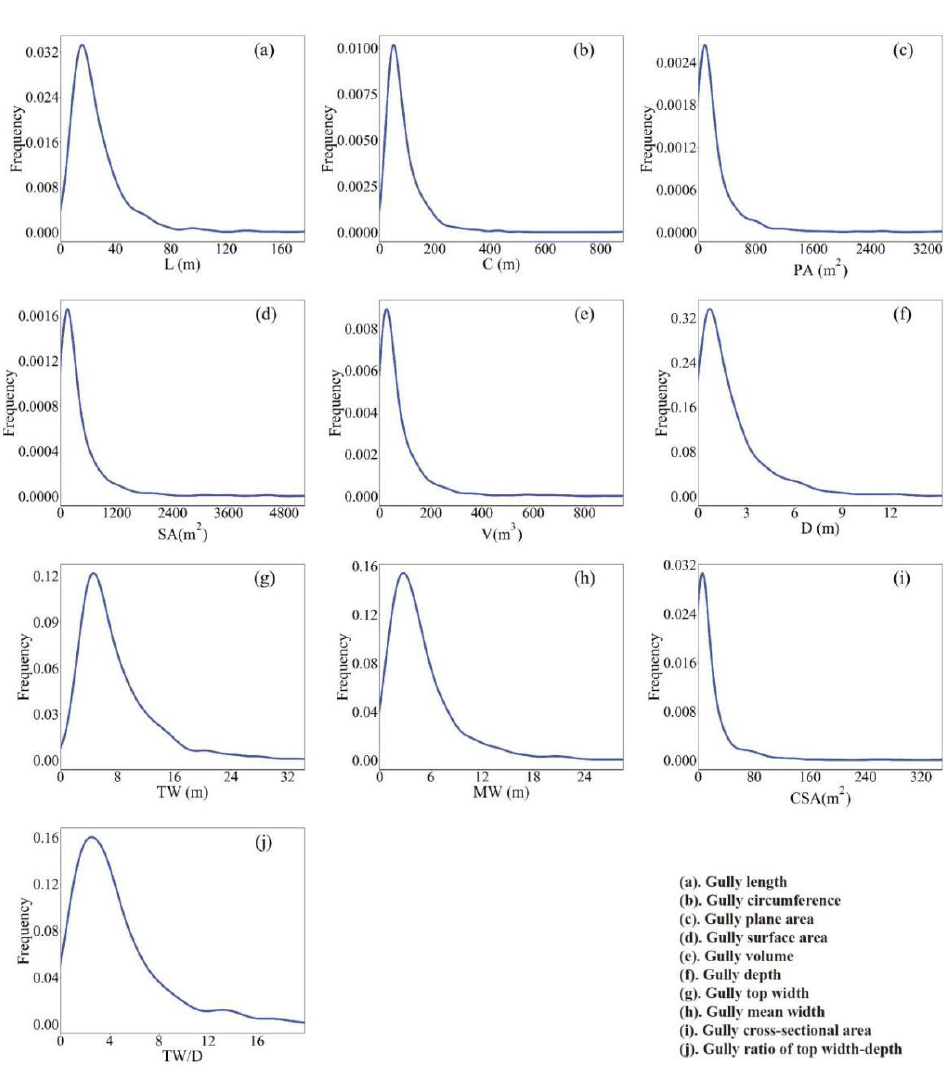
Figure 7. Gully morphological characteristics measured by UAV images and UAV-derived DEM (n = 910); the y axis shows the relatively frequency of the characteristics.